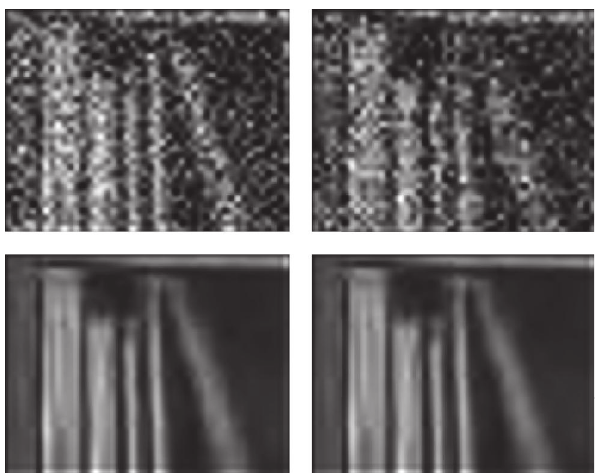
Figure 6: Zoom of noisy Salesman sequence ( 𝜎 𝑛 = 40 ). From left to right and from top to bottom: result of [18] algorithm, result of [19] algorithm, result of [13] algorithm, and result of the proposed algorithm.